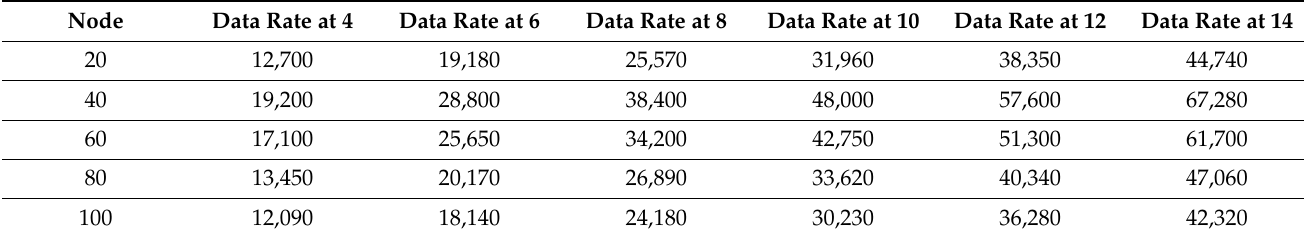
Table 6. Throughput based data set.